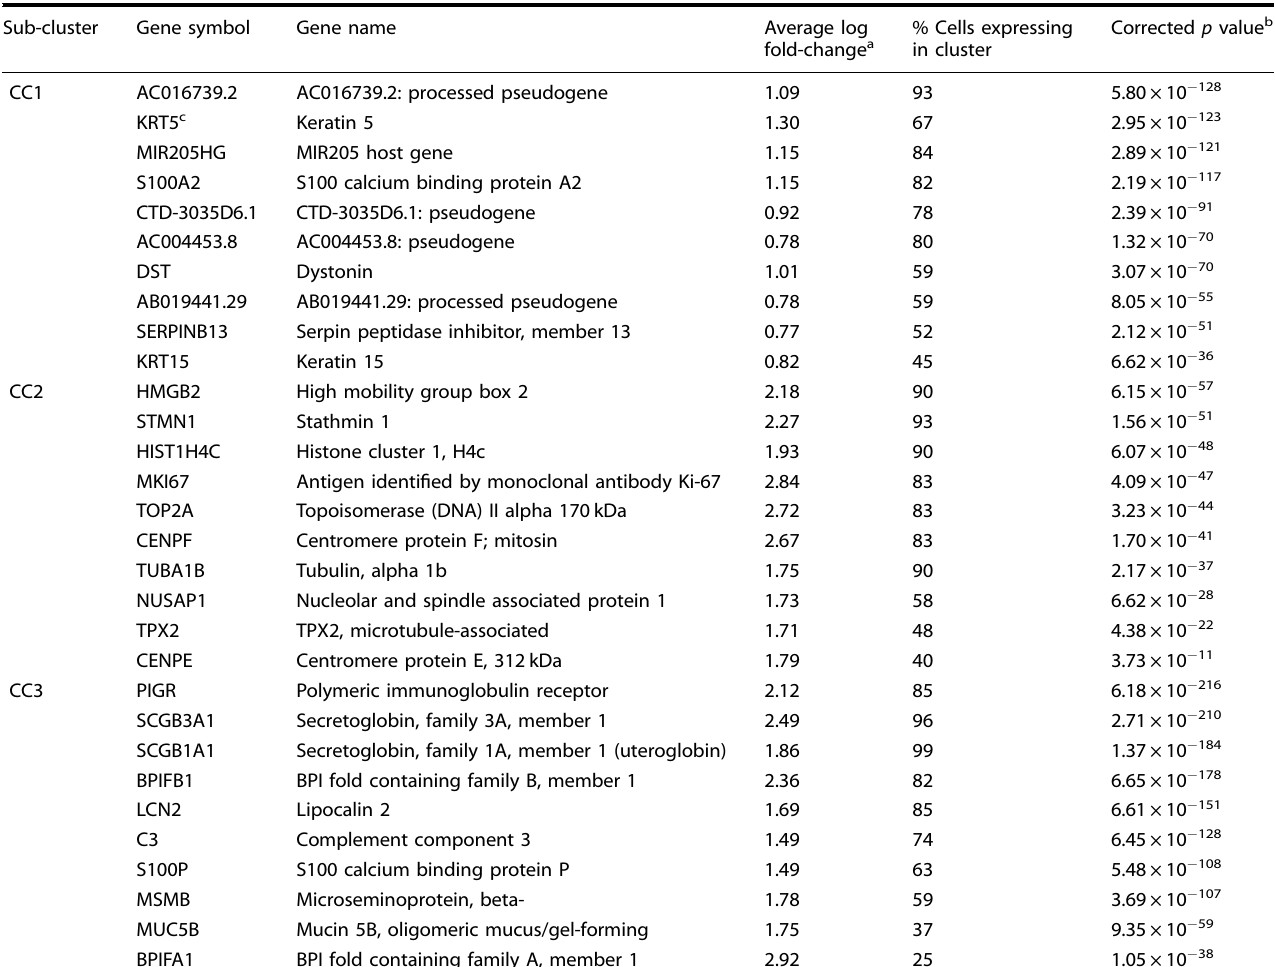
Table 1. Most commonly enriched genes in each club cell